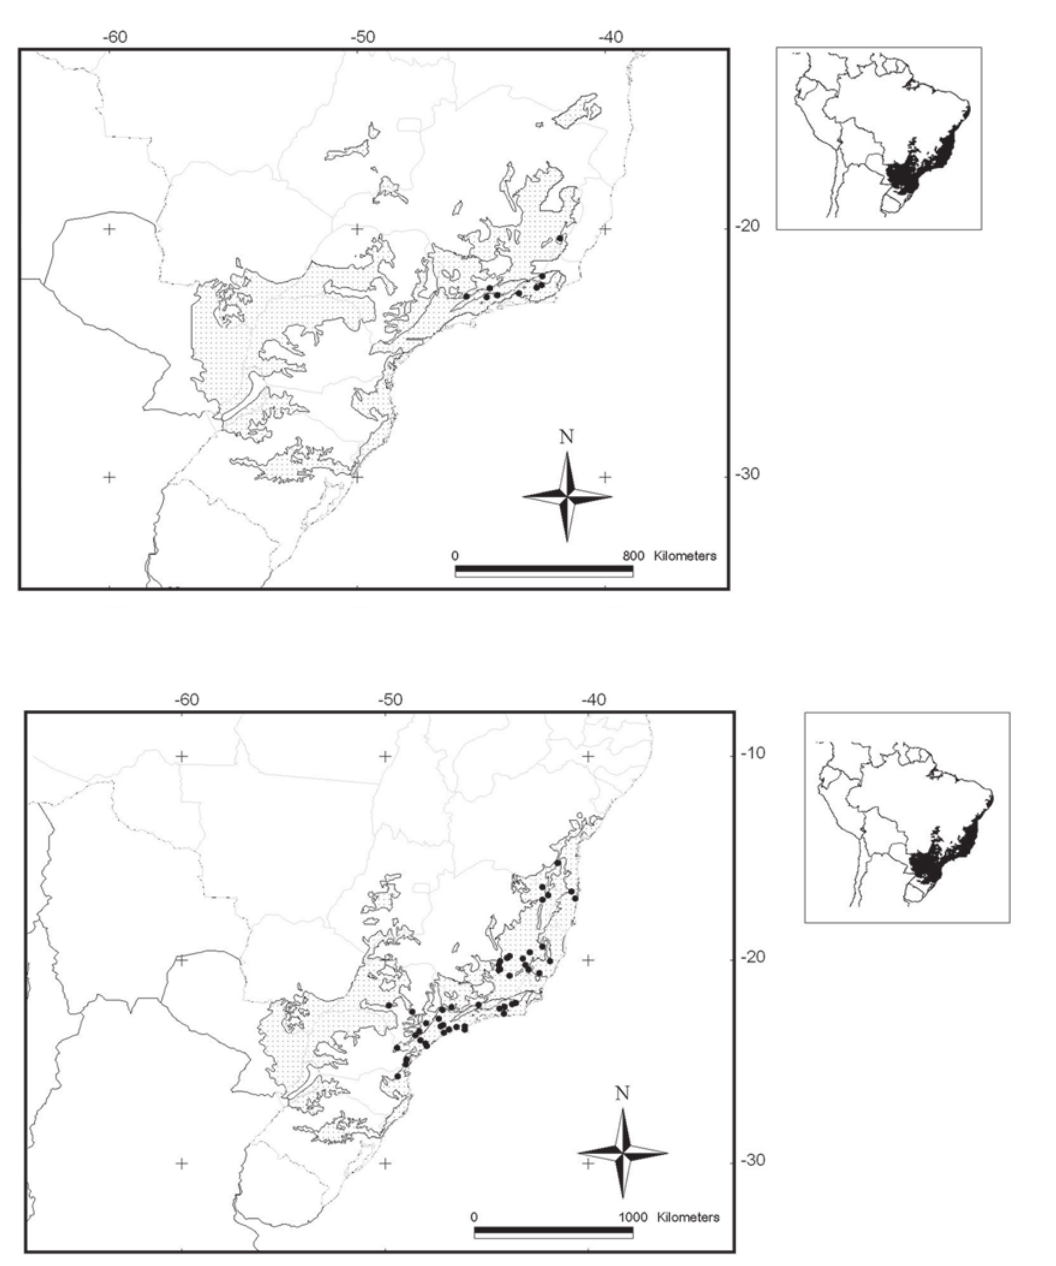
Figures 4-5. Potential distribution (shaded area) of Drymophila genei (4) and D. ochropyga (5). Dots are recording